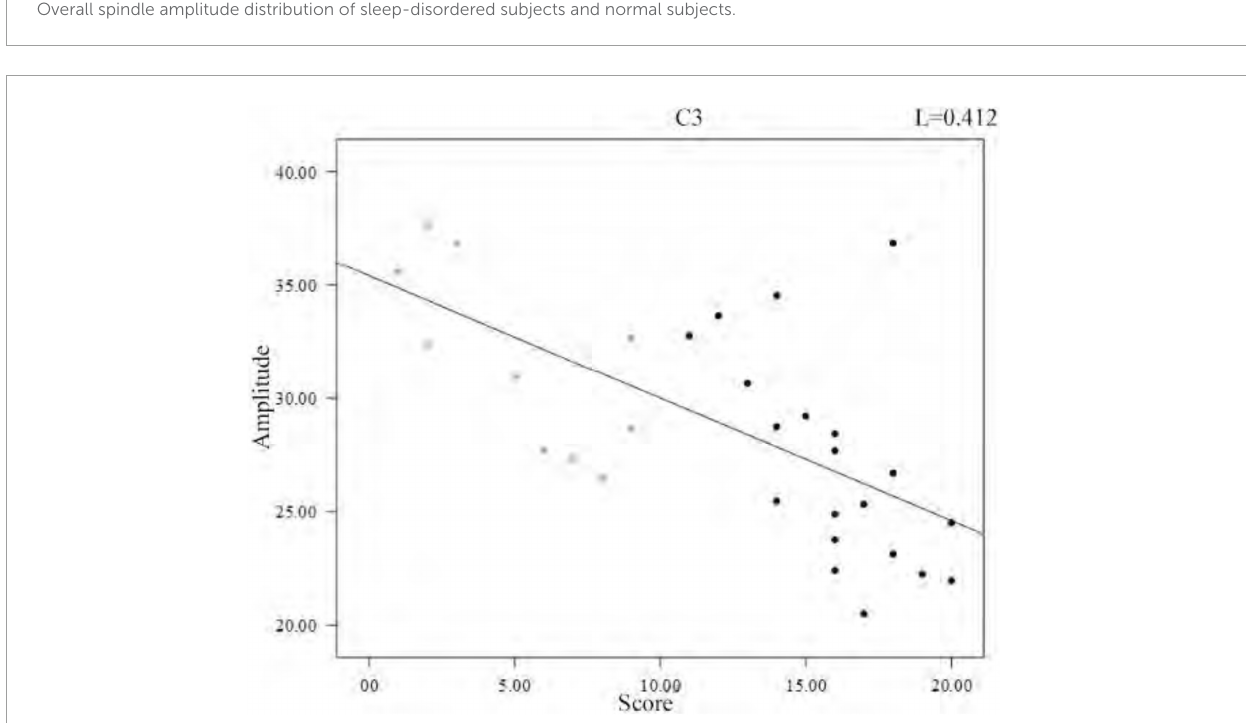
FIGURE9 Regression line of individual spindles mean amplitude and sleep quality